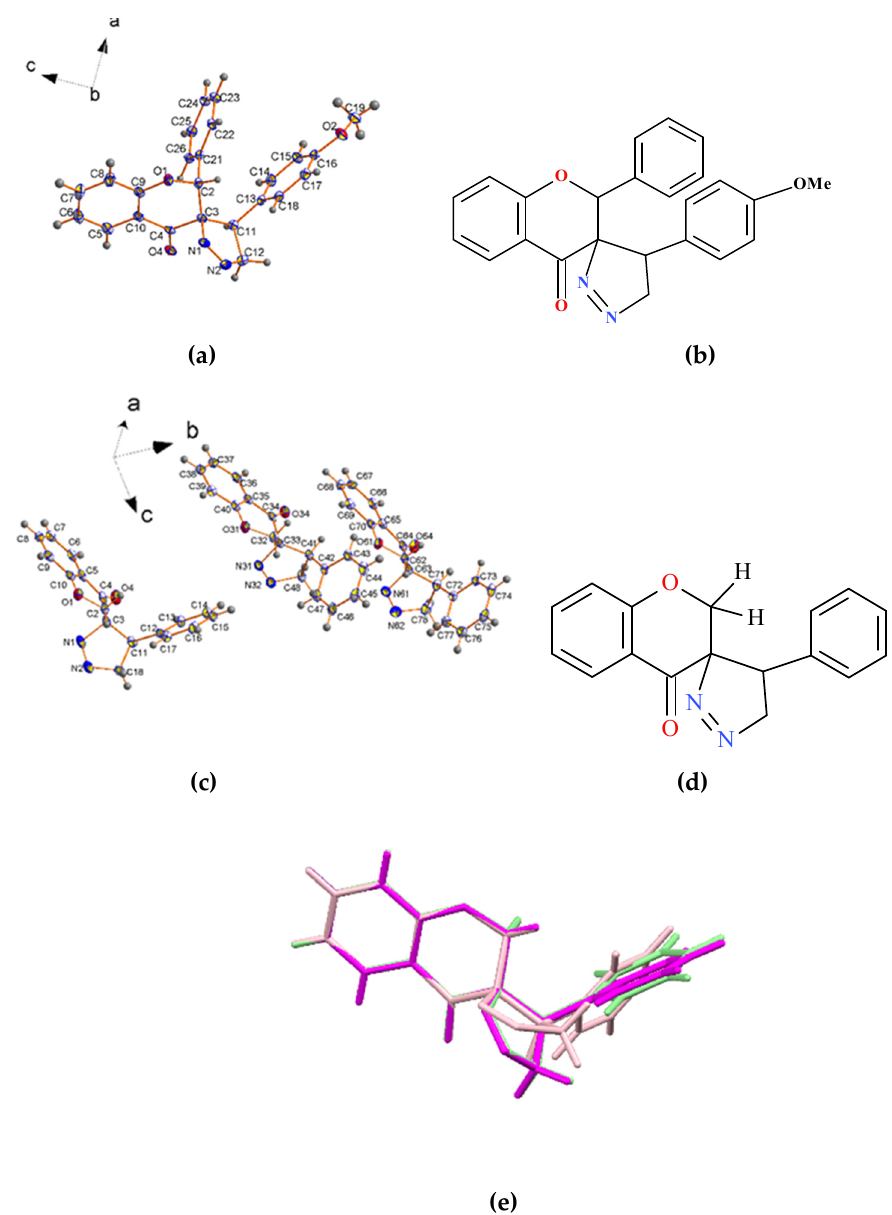
Figure 2. The molecular structure of 2 ( a ) and 8 ( c ) with an atom numbering. The chemical structure of 2 ( b ) and 8 ( d ). Scheme. ( e ) represents the overlay of three molecules in the asymmetric unit in the compound 8 crystal structure.